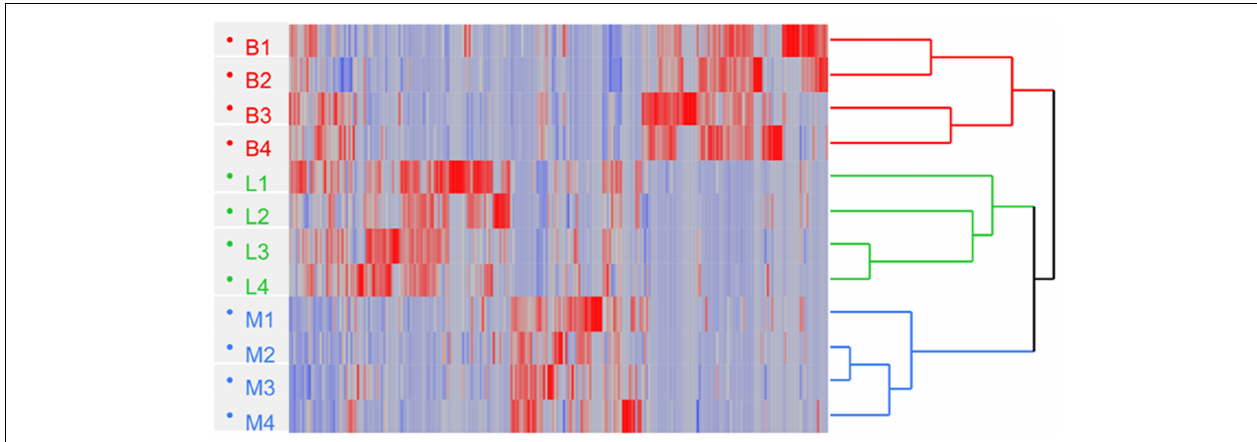
FIGURE 3 | Hierarchical clustering of L. delbrueckii subsp. bulgaricus (B; n = 4), lactis (L; n = 4), and L. delbrueckii 23 (M; n = 4) obtained by processing the SpC (Spectral Count) of proteins; Euclidean’s distance and Ward method were applied. Heat map shows the SpC and indicates down (blue) and up-regulated (red) proteins,